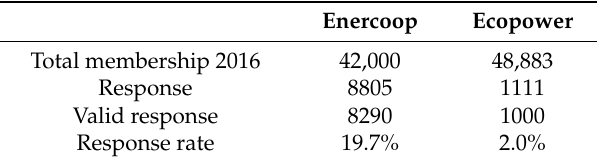
Table 3. Response survey for both Enercoop and